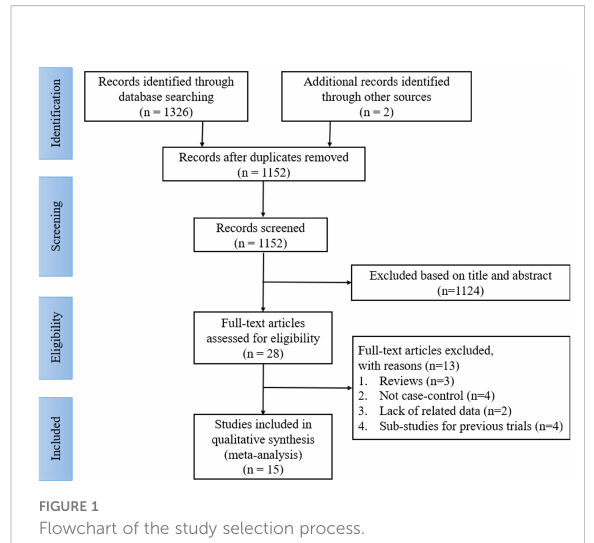
FIGURE 1 Flowchart of the study selection process.